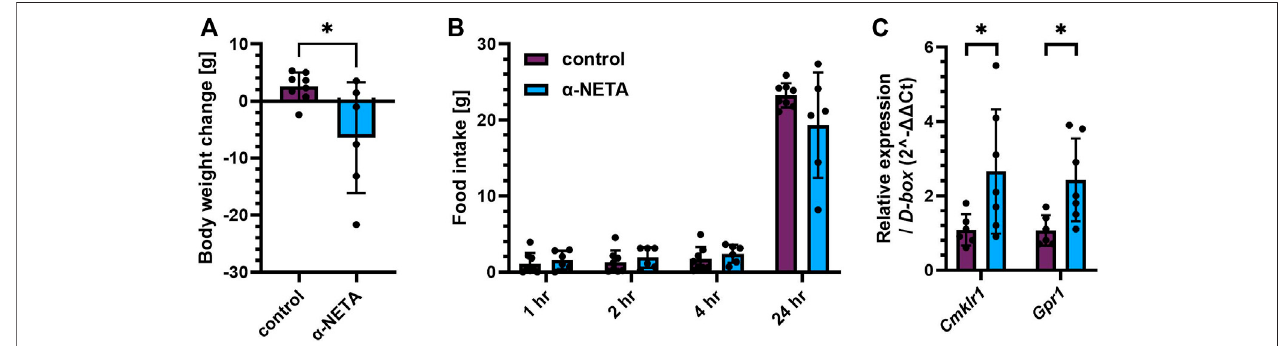
FIGURE 2 | Blocking CMKLR1 with α -NETA reduced body weight and increased Cmklr1 and Gpr1 expression. High-fat diet (45%) fed Sprague Dawley rats received an i.c.v. injection of 5 µl saline (control, n = 8) or 9.2 ng in 5 µl α -NETA ( n = 6) (A) Body weight change and (B) food intake was measured 1, 2, 4 and 24 h after